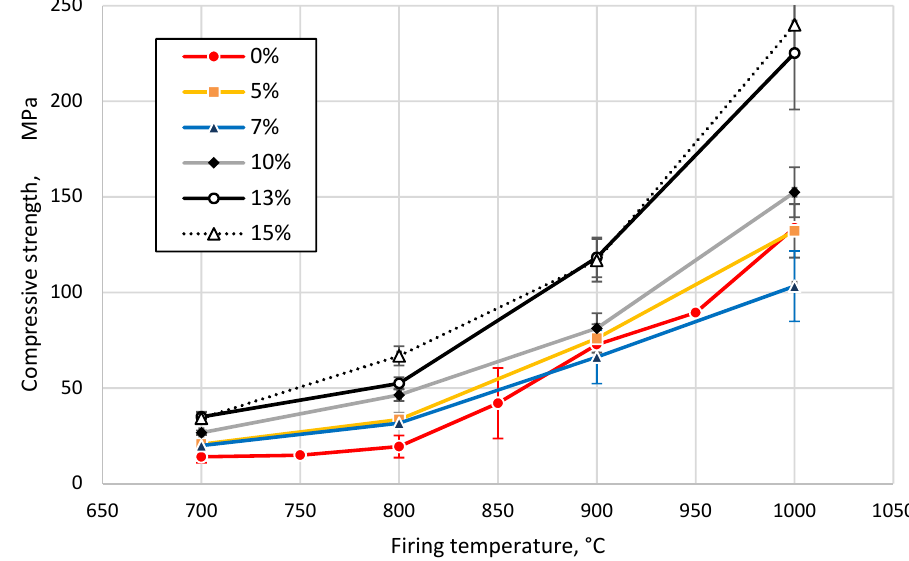
Figure 11. Compressive strength of tested clay-glass ceramic materials after sintering at temperatures from 700 up to 1000 °C. The content of glass in wt% is in the legend.